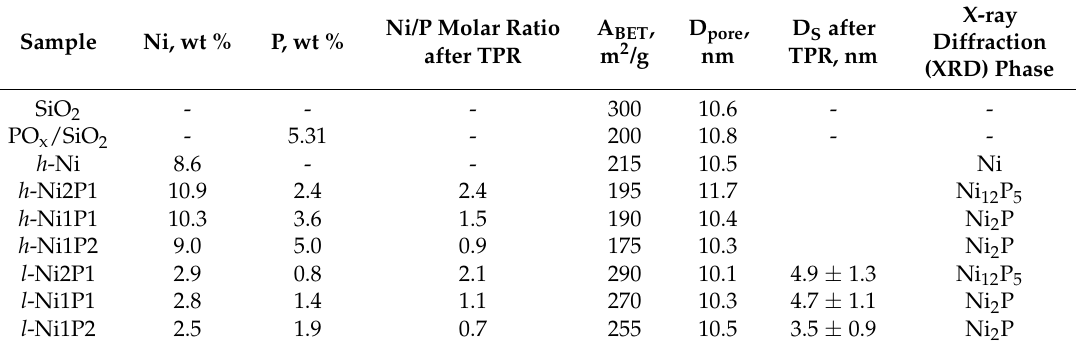
Table 1. Physicochemical properties of Ni x P y /SiO 2 catalysts as well as the reference samples Ni/SiO 2 , PO x /SiO 2 and SiO 2